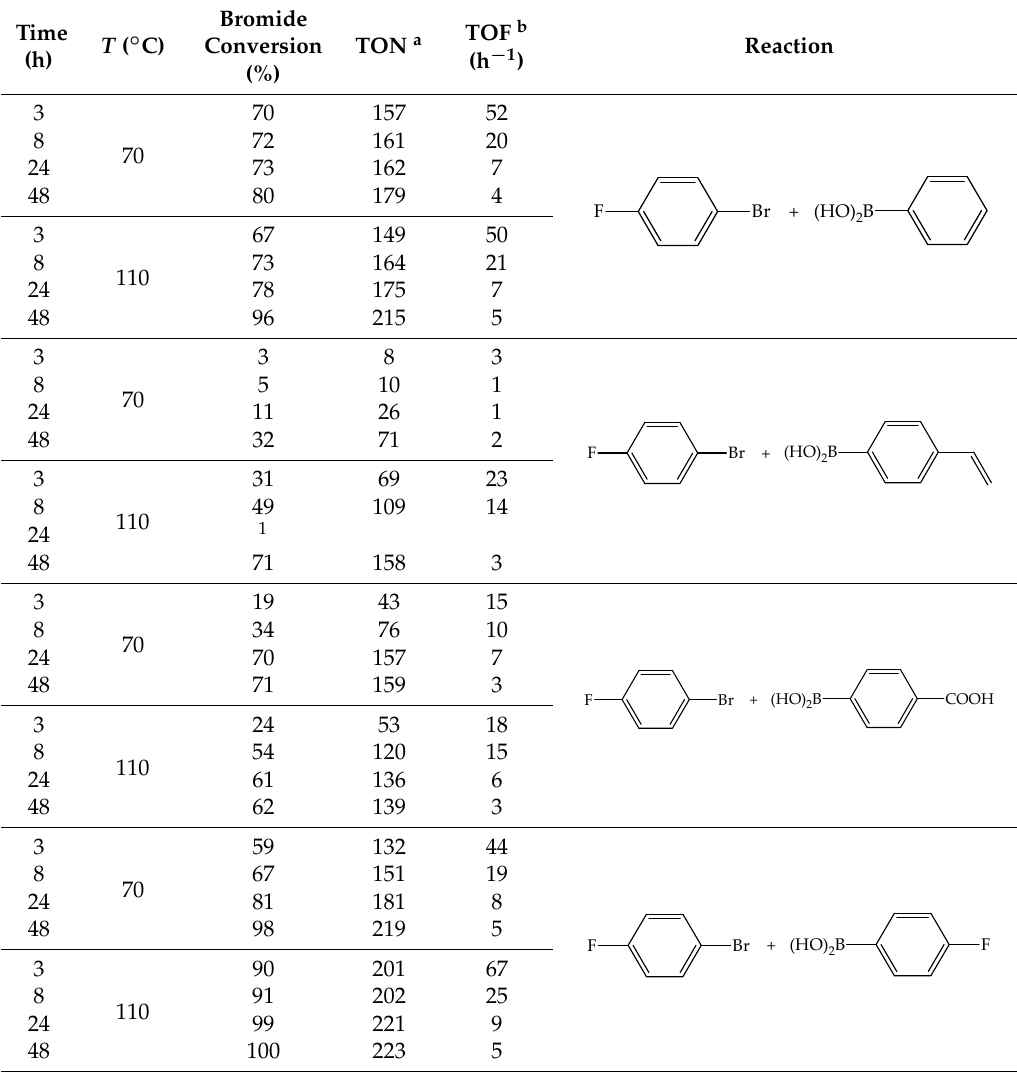
Table 2. Bromide conversions in C ‐ C coupling reactions using 1 ‐ bromo ‐ 4 ‐ flurobenzene and different boronic acids catalyzed by G ‐ COOH ‐ Pd ‐ 10.